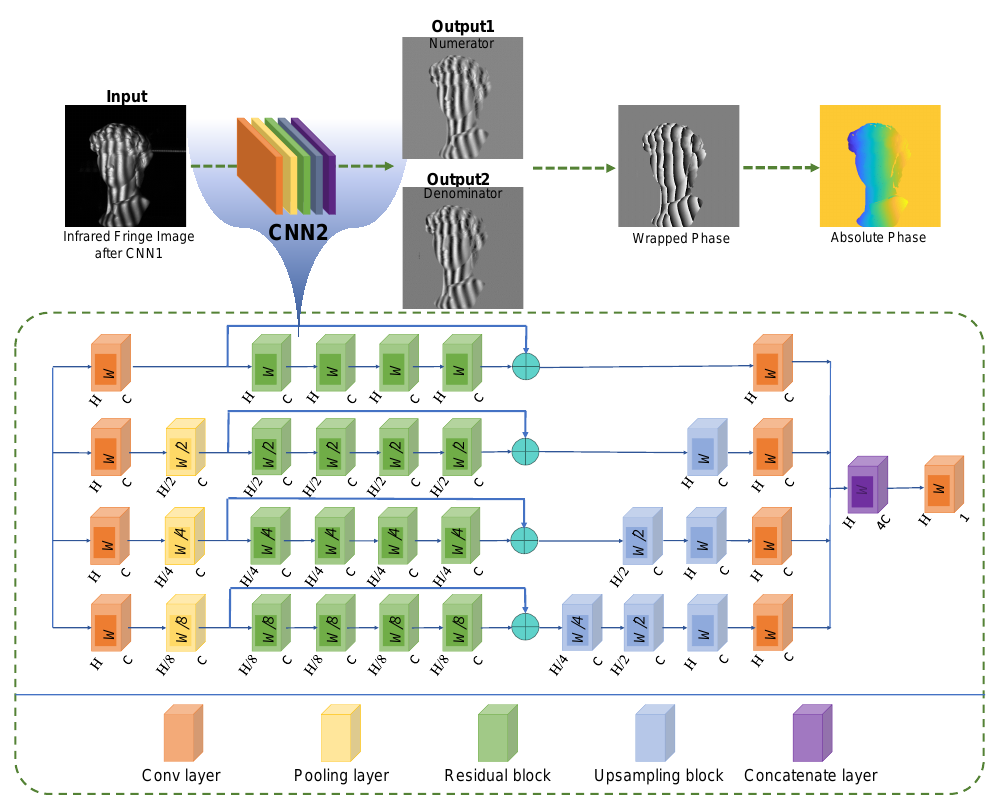
Figure 3. Schematic representation of phase information in fringe images demodulated using deep neural network